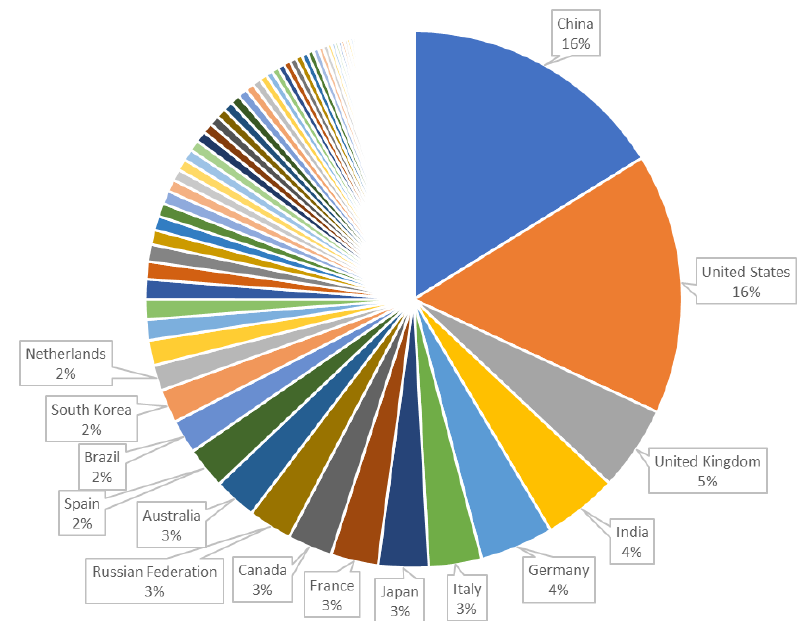
Figure 4. Top most productive countries in all scientific fields in 2020 (source Scopus).